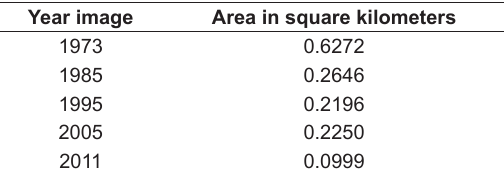
Table 6. Years of images and areas.